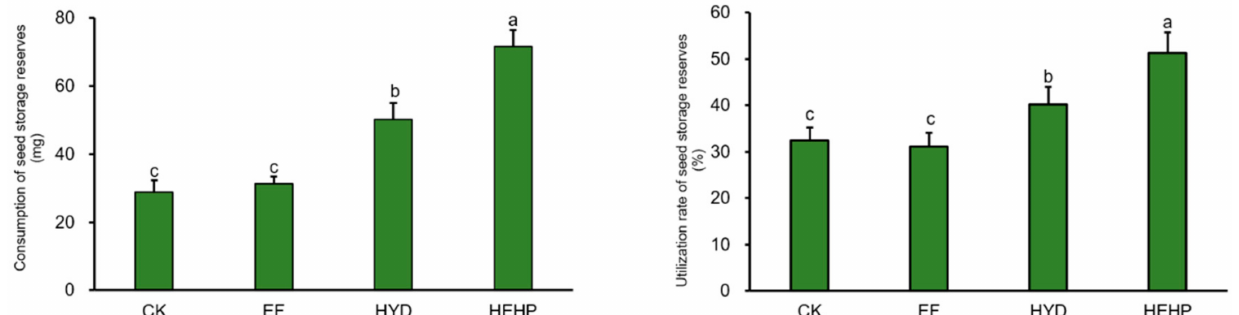
Figure 2. Changes of the consumption and utilization rate of carrot seed storage reserves after different priming treatments. Values represent the means ± SE from three biological replications. The different lowercase letters above the bars indicate significant differences in 95% probability level ( p < 0.05, Duncan test was performed after ANOVA